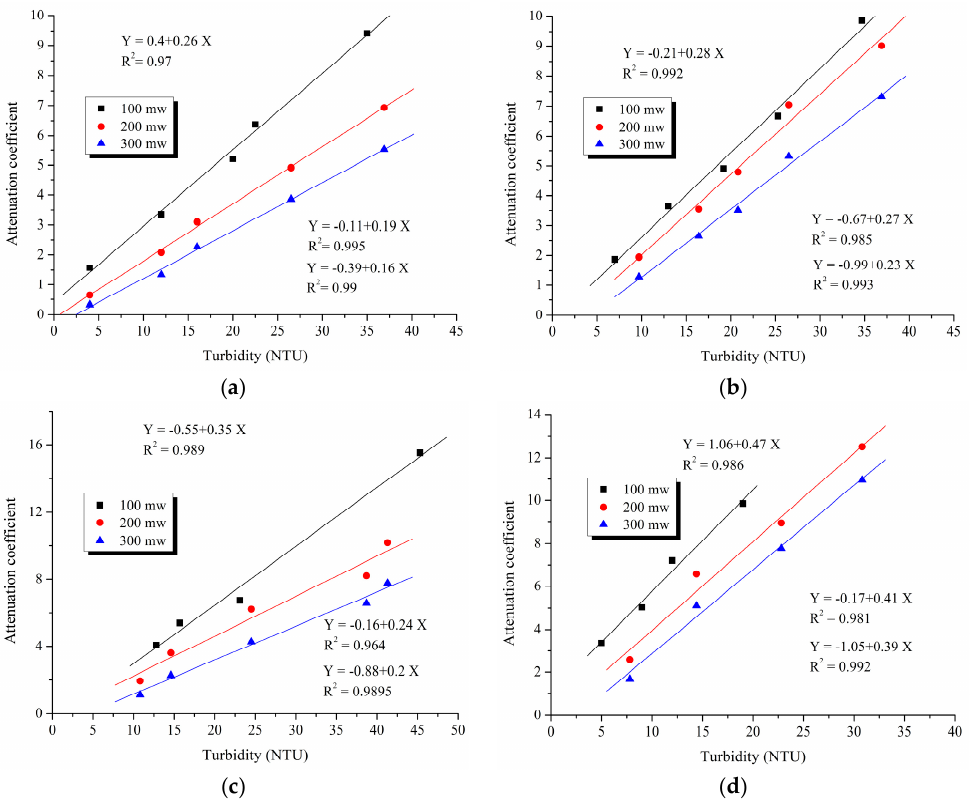
Figure 7. Attenuation coefficient—turbidity curve with lasers of different power levels: ( a ) CaCO 3 ; ( b ) silt; ( c ) clay; ( d ) SiO 2 .